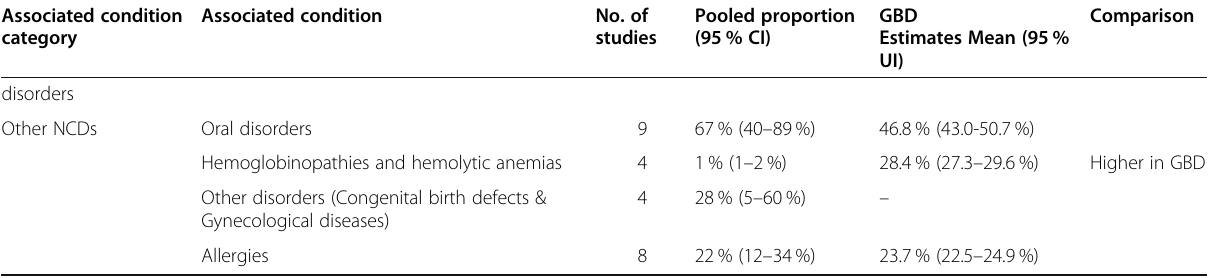
Table 2 Pooled prevalence of selected comorbidities among patients with primary headaches and comparison with 2019 GBD Estimates